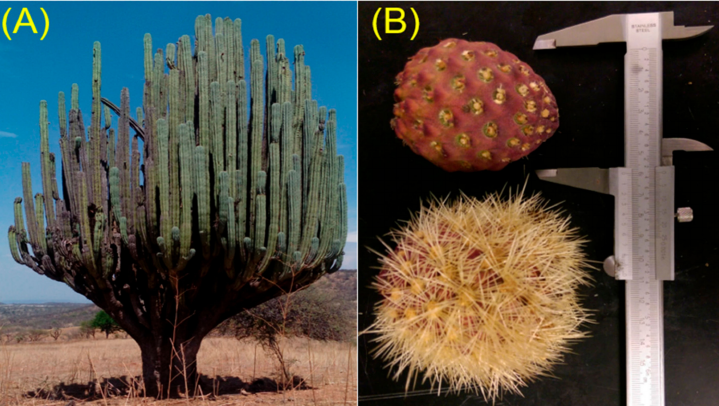
Figure 1. ( A ) Pachycereus weberi plant and ( B ) P. weberi fruit without prickles (top) with prickles